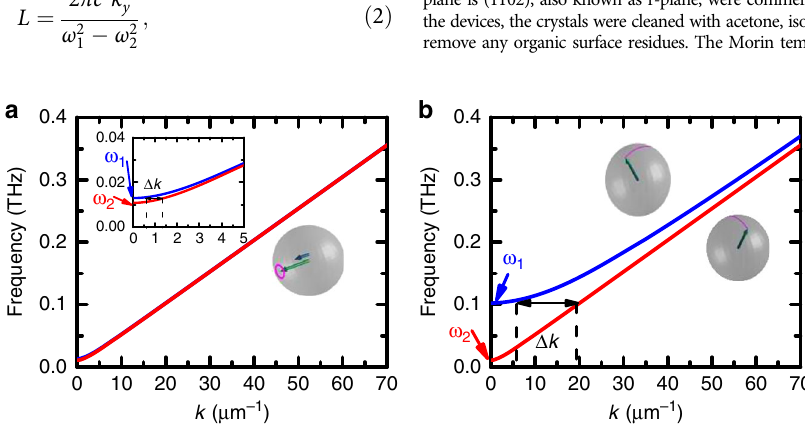
Fig. 4 Magnon dispersion curves of the two magnon modes of an easy-plane antiferromagnet. a Low (close to the Morin transition) and b high anisotropy (far from the Morin transition, here + 30 K 29 ). The pairs of magnons which satisfy energy conservation have small (large) Δ k for low (high) anisotropy. For the calculations, we use a limiting magnon velocity c = 5.10 4 m/s as estimated from the magnon dispersion of Martin et al. 40